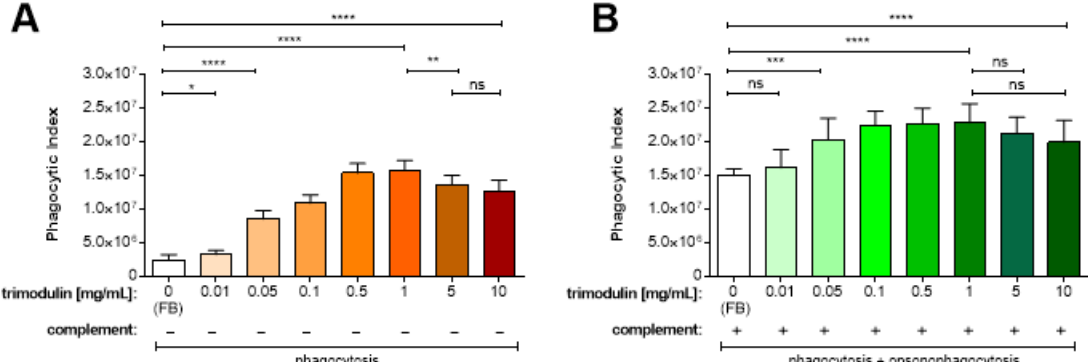
Figure 1. Trimodulin induces concentration-dependent phagocytosis and opsonophagocytosis of S. aureus bioparticles. ( A ) Phagocytosis and ( B ) (opsono)phagocytosis of S. aureus bioparticles by differentiated HL-60 cells in the absence of complement ( − , with hiNHS min ), or in the presence of active complement (+, with NHS min ), respectively. Additionally, assays included no (0, white bars, with FB only) or different trimodulin concentrations as indicated below the figures, representing final trimodulin concentrations in the assays. Bars represent mean + standard deviation (SD, n = 6 independent experiments). Reactions without active complement ( − ) display phagocytosis activity. Reactions with active complement (+) display phagocytosis plus opsonophagocytosis. Statistical analyses were performed using an unpaired Wilcoxon–Mann–Whitney test. Significance is shown with asterisk indicating a p -value of: * p < 0.05; ** p < 0.01; *** p < 0.0005; **** p < 0.0001; ns: non-significant. FB: formulation buffer; NHS min : normal human serum depleted for IgM and IgG; hiNHS min : heat-inactivated NHS min ; SD: standard deviation.